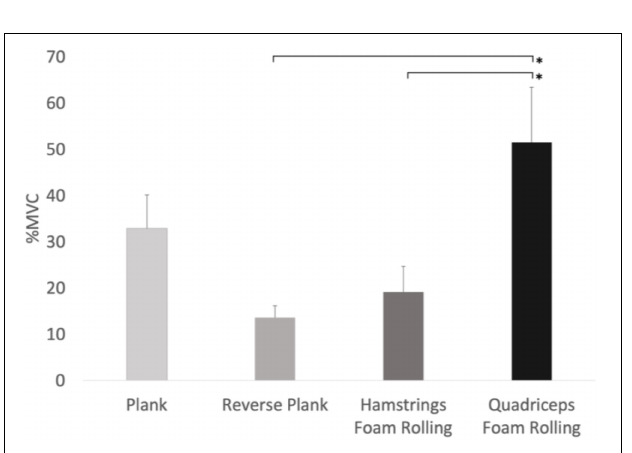
FIGURE 3 | Main effect for conditions with lower abdominal muscle EMG activity. ∗ Significant difference between the conditions ( p < 0.05), %MVIC refers to